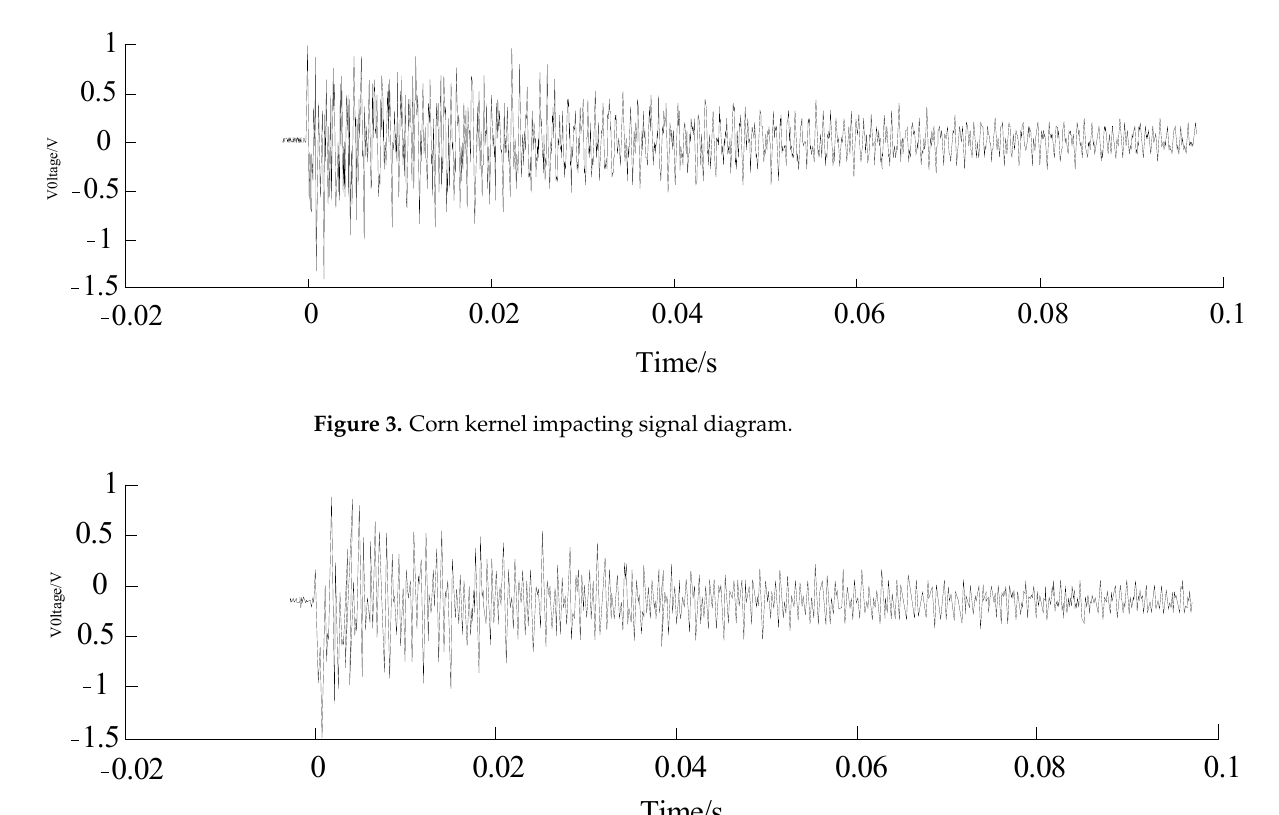
Figure 4. Impurity impacting signal diagram.